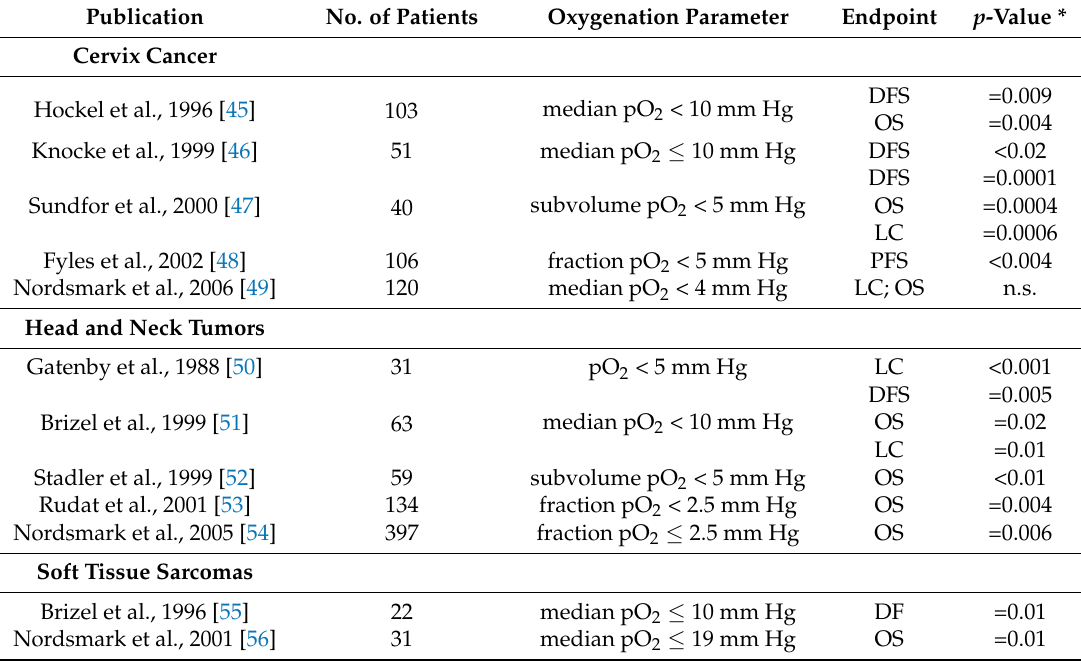
Table 1. Prognostic significance of hypoxia for irradiated cancer in different